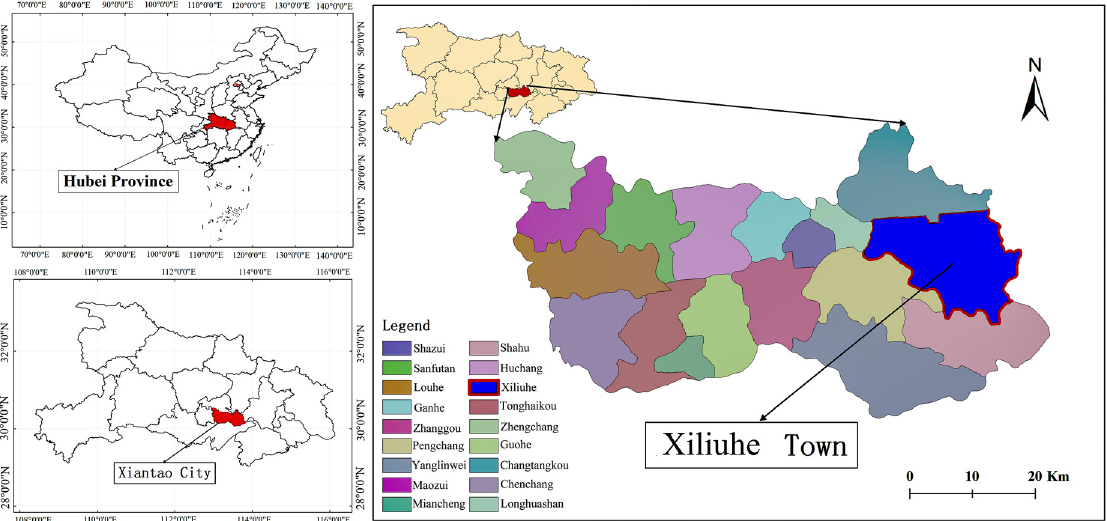
Figure 2. Study Figure 2. Study area.